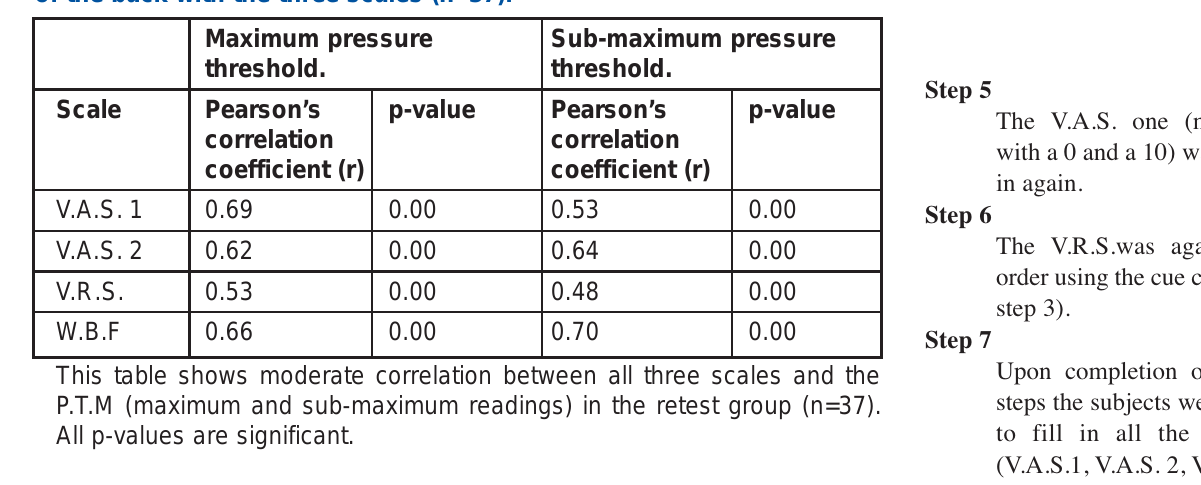
Table 5: Correlation between maximum and sub-maximum P.T.M. readings of the back with the three scales (n=37).